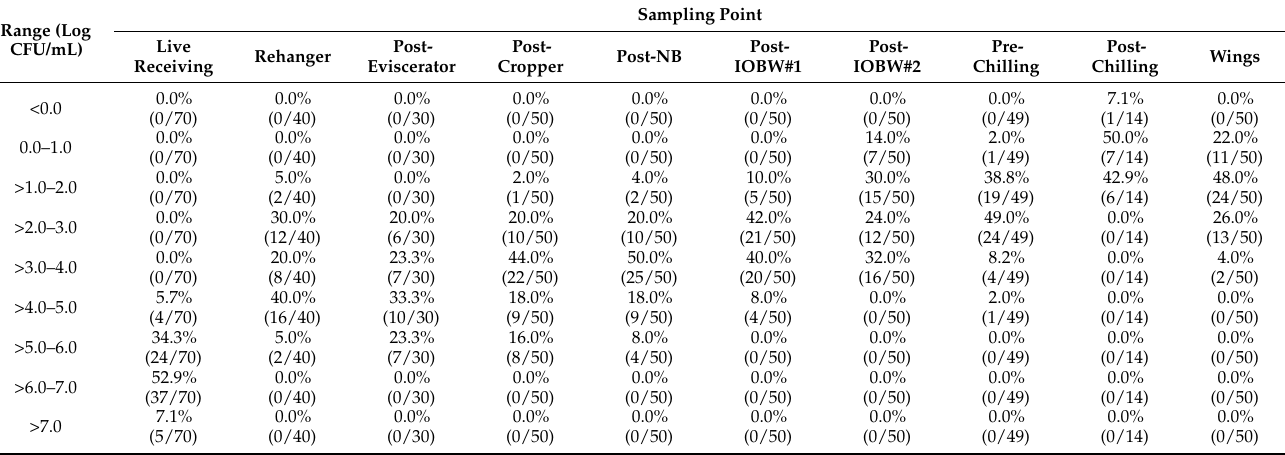
Table A1. Distribution of Enterobacteriaceae counts (Log CFU/mL) on each of the ten sampling locations under normal process intervention on chicken and part rinses (n = 453 samples).